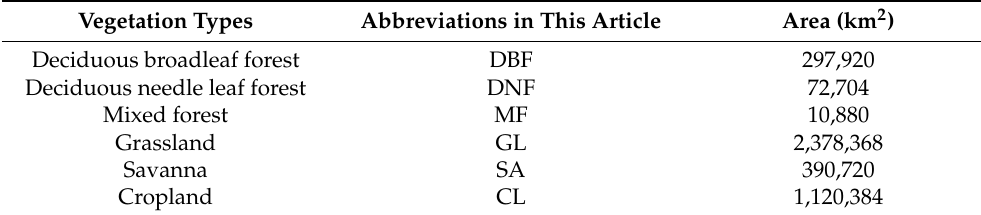
Table 1. Selected vegetation